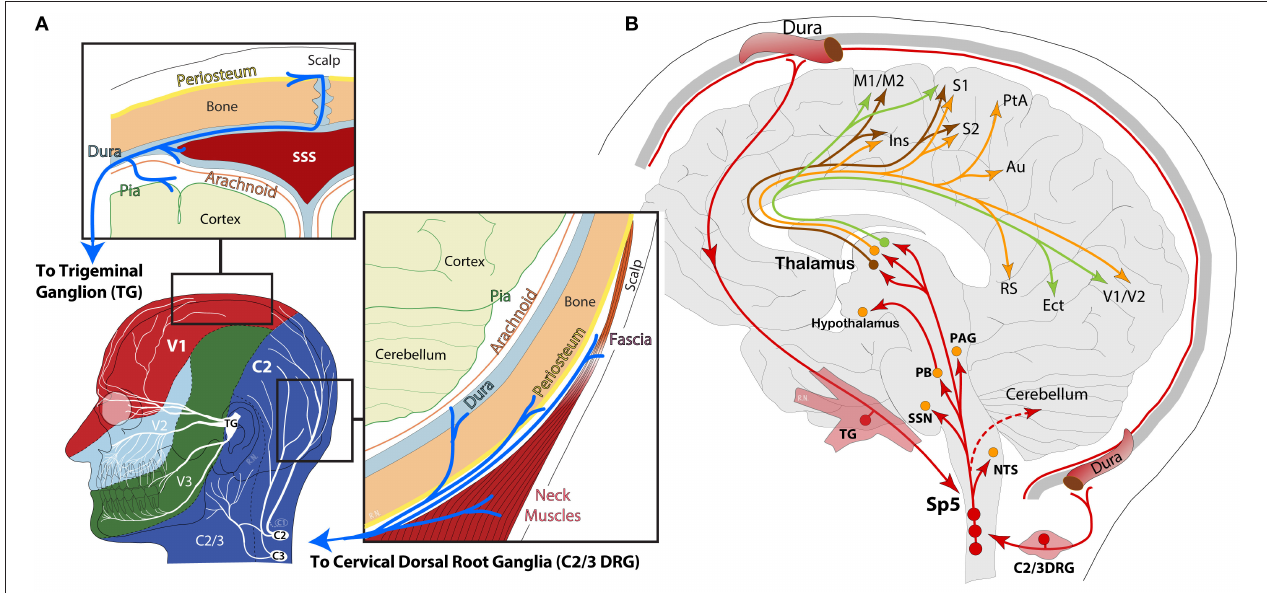
FIGURE 1 | (A) Schematic representation of head and face dermatomes innervated by the ophthalmic (V1), maxillary (V2), and mandibular (V3) branches of the trigeminal nerve and upper cervical spinal nerves (C2/3). Insets highlight the dural innervation by the trigeminal ganglion and the cervical dorsal root ganglion, containing peripheral sensory neurons. SSS: superior sagittal sinus; (B) schematic representation of ascending nociceptive pathways from the dura to 2nd-order neurons in the spinal trigeminal nucleus (Sp5). From Sp5, ascending axonal projections have been reported in the nucleus of the solitary tract (NTS), superior salivatory nucleus (SSN), parabrachial (PB), periaqueductal gray (PAG), hypothalamus, and thalamus. Lateral thalamic 3rd-order neurons in the ventral posteromedial (VPM), lateral posterior (LP), and posterior (Po) nuclei send dural nociceptive signals to motor (M1/M2), somatosensory (S1/S2, insula), parietal association (PtA), auditory (Au), retrosplenial (RS), ectorhinal (Ect), and visual (V1/V2) cortices.